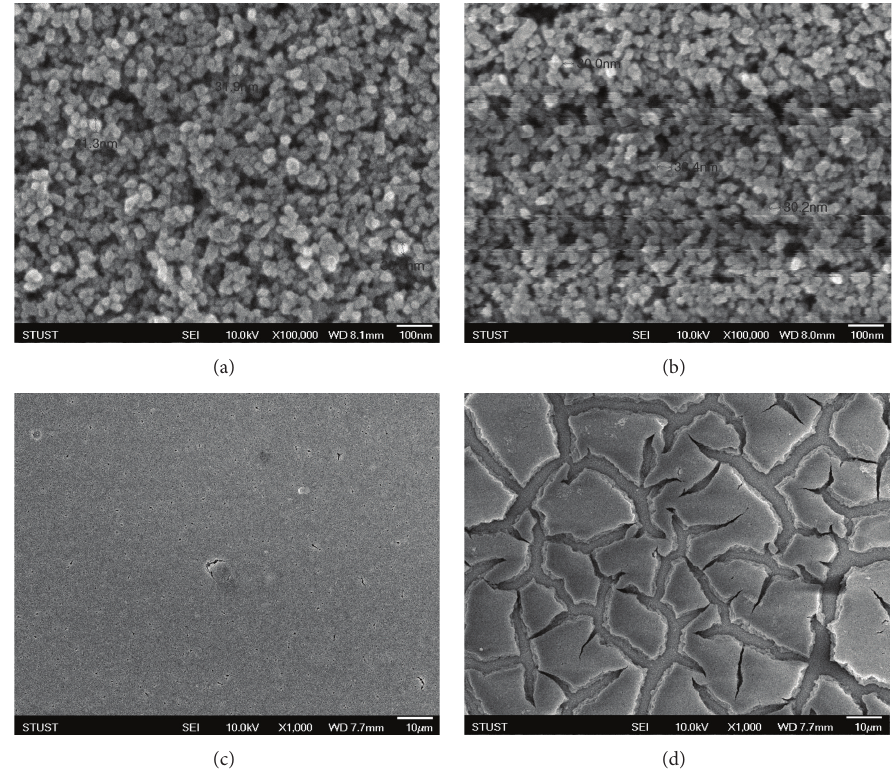
Figure 4: FESEM images of ((a), (c)) bare TiO 2 film and TiO 2 film after use of (b) 5 × 10 −3 M and (d) 5 M NaOH solutions as desorption agents.